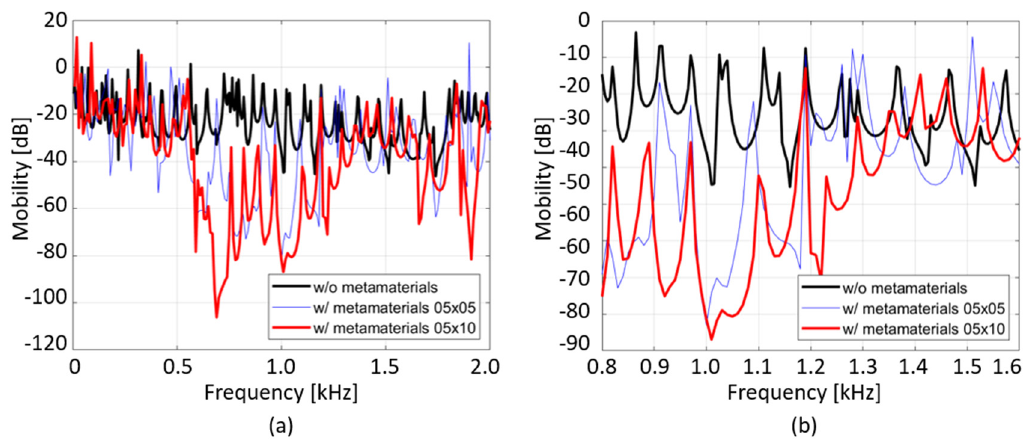
Figure 6. Frequency response of z-directional mobility of the bare plate and plate with interconnected 5 × 10 and 10 × 10 metamaterials for ( a ) 0~2000 Hz and ( b ) the stopband (764–1613 Hz) .